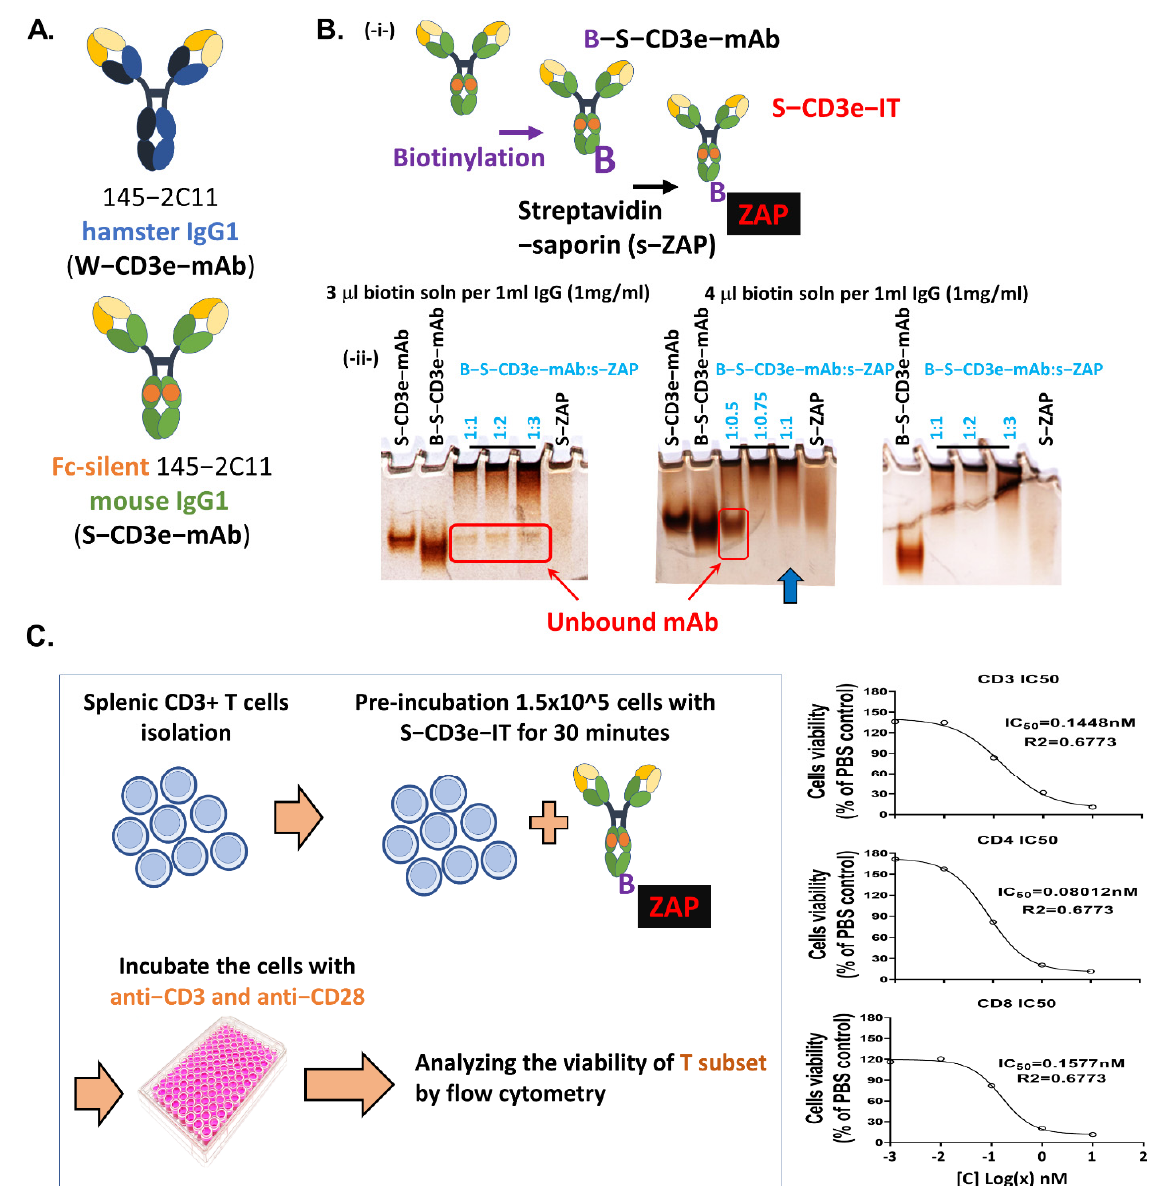
Figure 1. CD3e monoclonal antibodies and new antimurine CD3e immunotoxin. ( A ) Anti-murineCD3e monoclonal antibodies. Wildtype hamster 1452C11 (W-CD3e-mAb) or chimeric 1452C11 with Fc-silent mouse IgG1 (S-CD3e-mAb) were tested. ( B ) Generating a new anti-murineCD3e immunotoxin (SCD3eIT). ( -i- ) SCD3eIT was generated by first biotinylating SCD3emAbs (BSCD3emAb) and then conjugating BSCD3e-mAb to streptavidin–saporin (sZAP). ( -ii- ) Optimization of the biotinylation step and the antibodysZAP conjugation step. Biotinylation with 4 μ L biotin solution (FluoReporter Protein Labeling Kit, Invitrogen) per 1ml of 1mg/mL immunoglobulin G (IgG) and conjugation of BSCD3e-IT and sZAP at molar ratio of 1:1 (blue arrow) was an optimal condition to minimize unbound antibodies (red boxes). SCD3emAb, B-S-CD3e-mAb, different ratios of B-S-CD3e-mAb:sZAP, and sZAP are shown on 38% Tris–acetate gradient gels. ( C ) In vitro SCD3eIT assay. Splenic CD3+ T cells were incubated with 1 pM to 10 nM of S-CD3e-IT for 30 min, then incubated in antiCD3 and antiCD28 72 h. Cell viability was assayed by flow cytometry analysis. Cell viability at different concentrations of SCD3eIT was normalized with that of no-treatment (PBS) control.